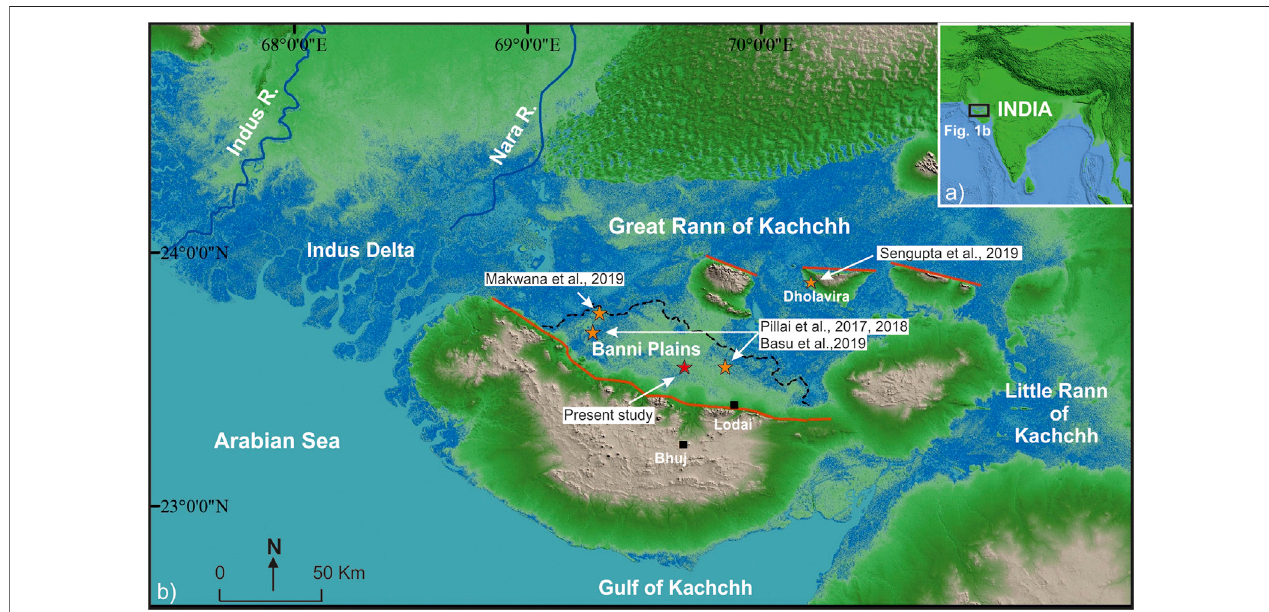
FIGURE 1 | Digital elevation model of Kachchh showing the location of the study area and trench site in Kachchh.